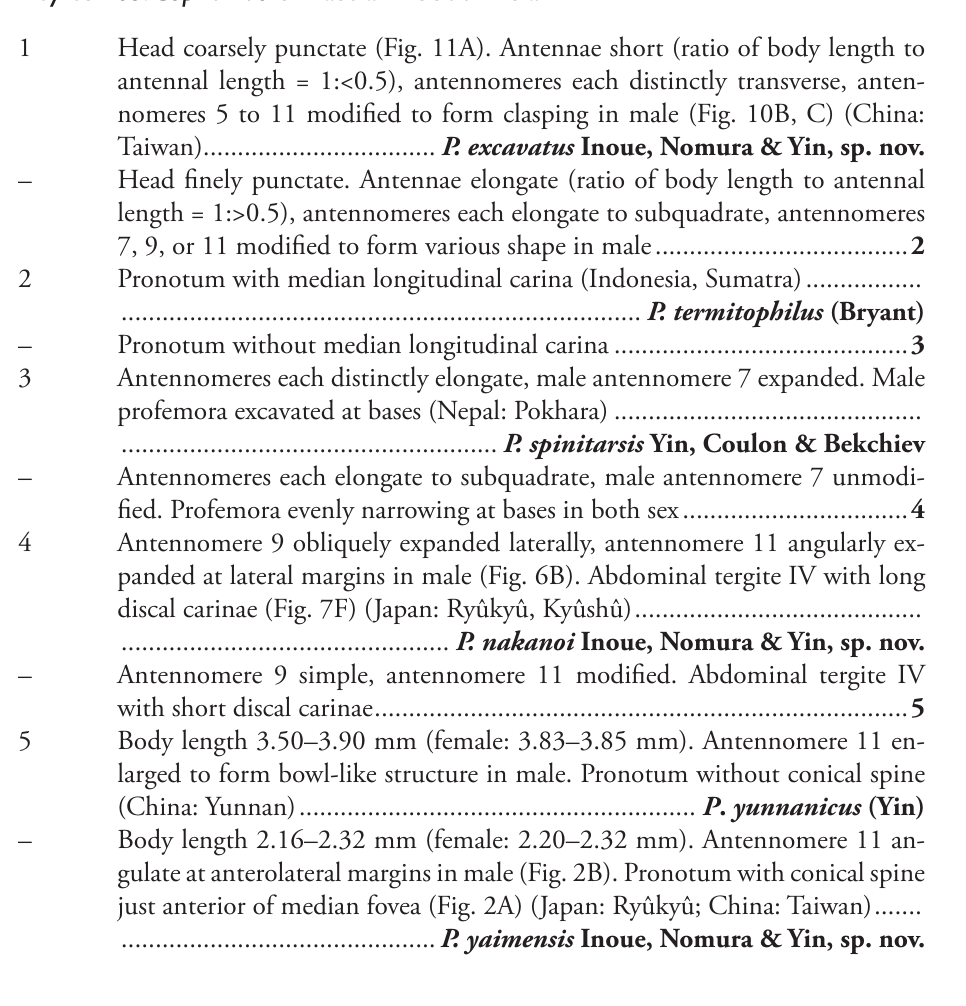
[Japanese name: Yaima-tsumugata-arizukamushi] Type material. Holotype (NSMT): ♂ , “Japan: [Ryûkyû], Ishigaki- / jima, Takeda- rindô 23 X 2007, Teruaki Ban leg. // HOLOTYPE (red) / ♂ , Pseudophanias yaimensis sp. nov., / det. Inoue, Nomura & Yin, 2020” Paratypes : Japan: 1 ♀ , [Ryûkyû],